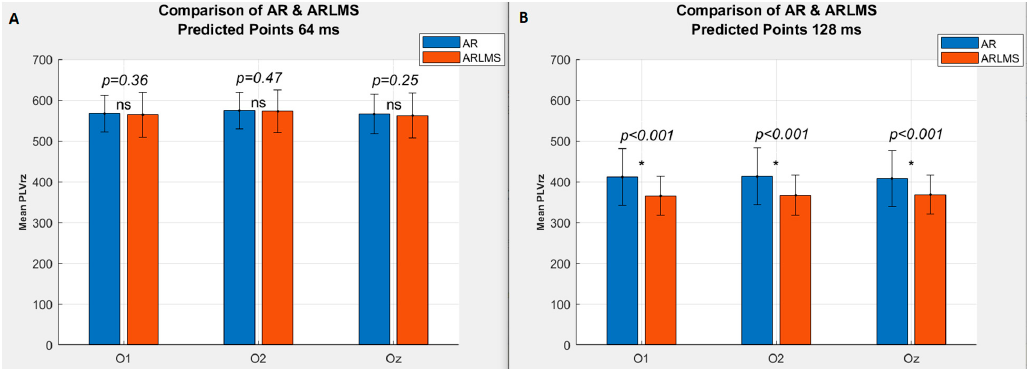
Figure 4. Rayleigh's PLV for the AR model and the LMS-based AR model, ns represents not significant p -value while Asterisk (*) indicates significant p -value. ( A ) Mean of Rayleigh's Z value (PLVrz) at the current time point (64 ms); ( B ) Mean PLVrz at the 128 ms. Error bars indicate the standard deviation of the mean.